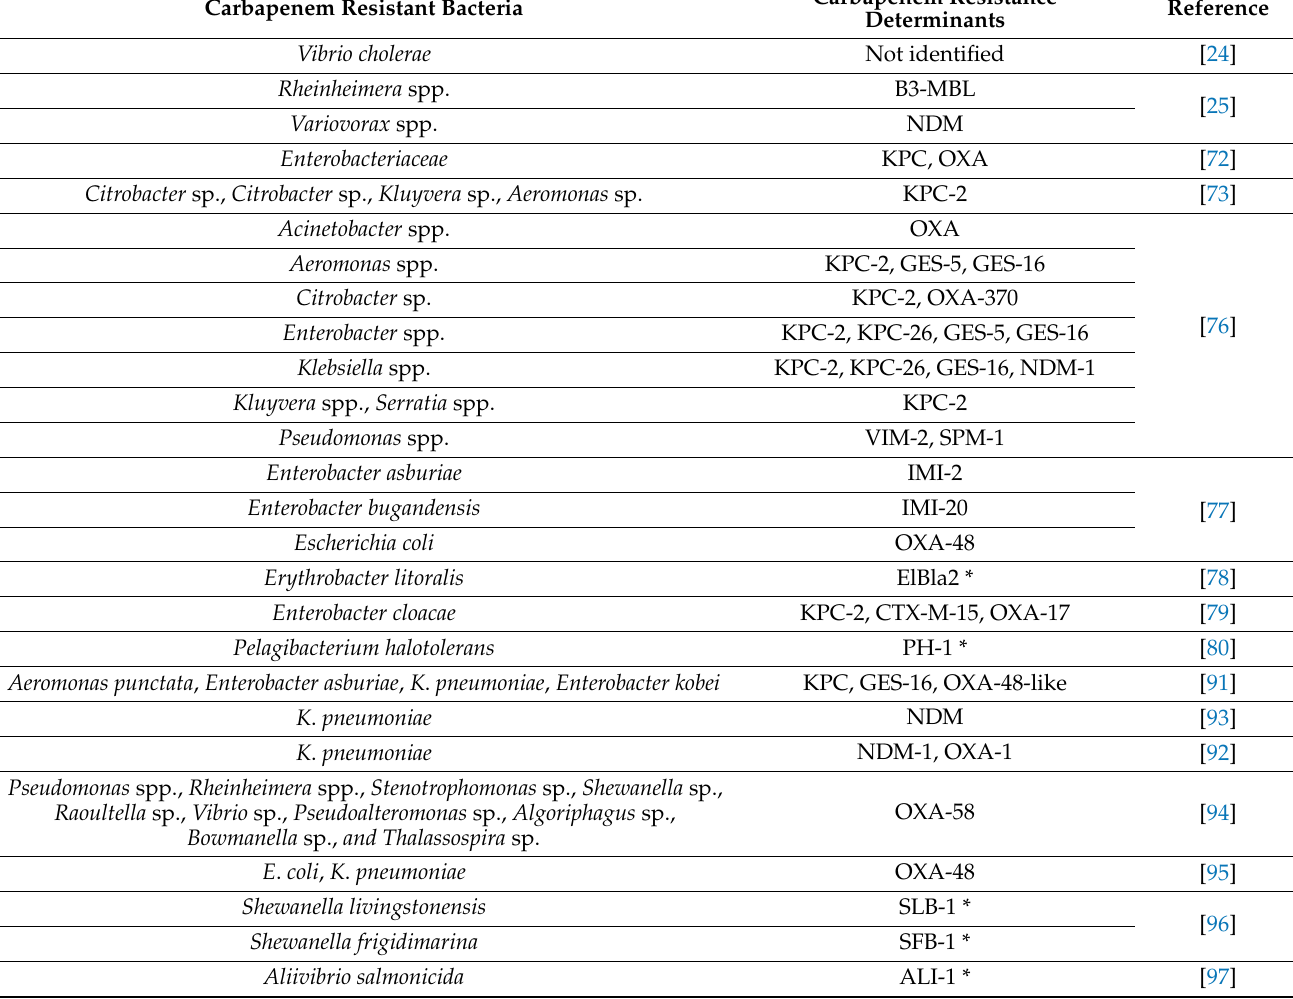
Table 1. Carbapenem-resistant bacteria and carbapenem resistance genes found in coastal environments. Carbapenem Resistant